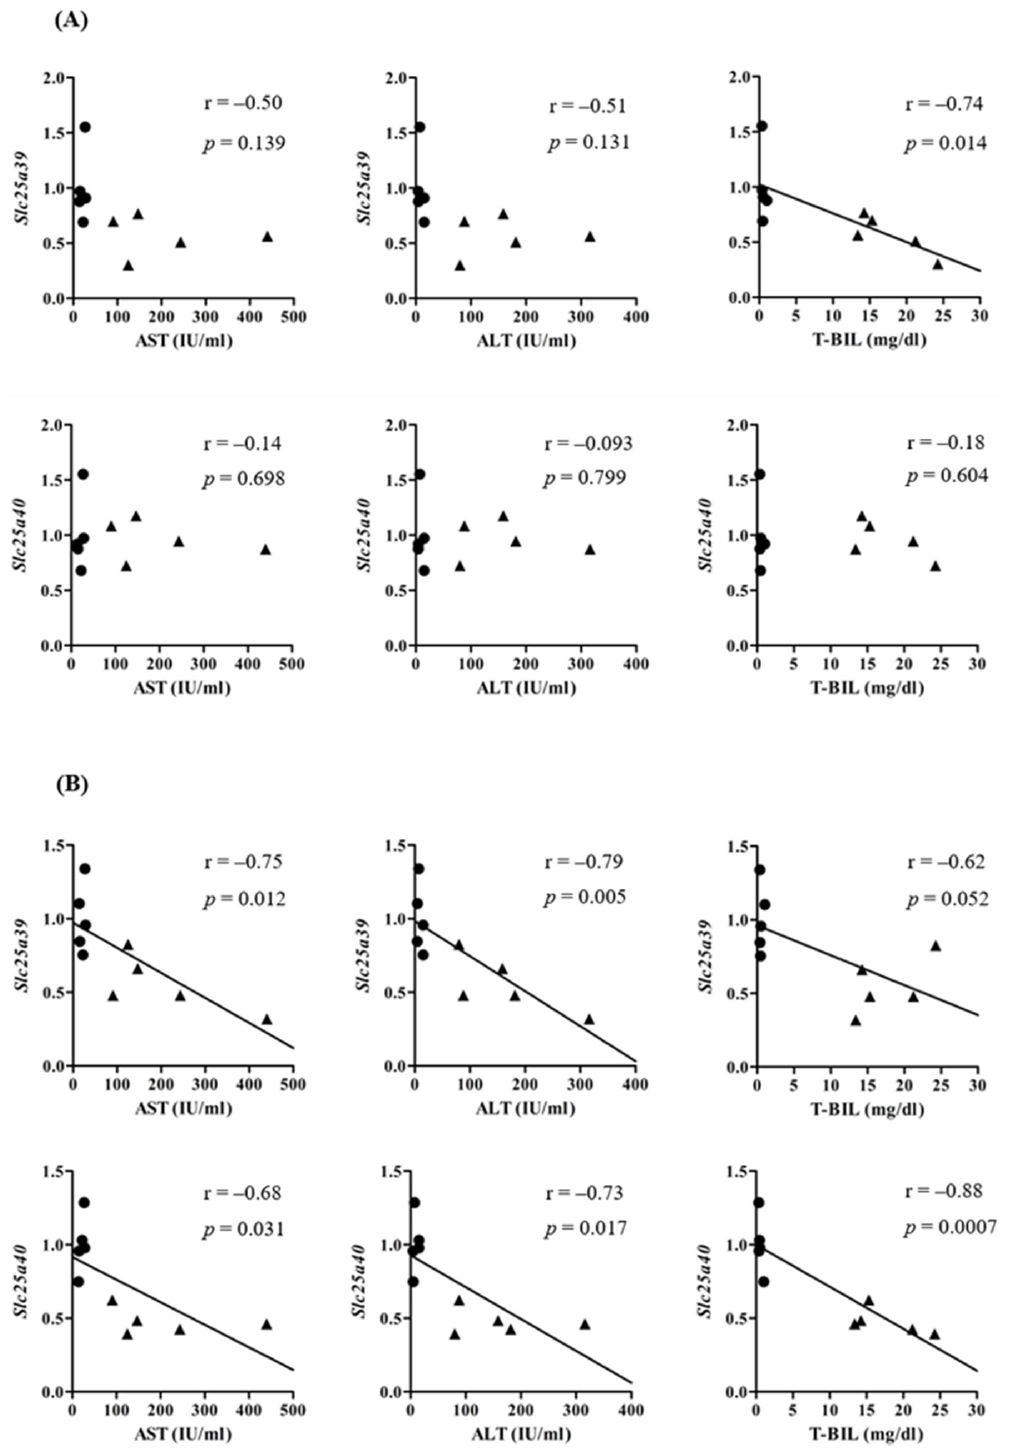
Figure 3. Correlation between aspartate aminotransferase (AST; IU/mL), alanine aminotransferase (ALT; IU/mL), or total bilirubin (T-BIL; mg/dL), and relative mRNA levels of Slc25a39/40 in the liver ( A ) and kidneys ( B ) of sham and bile duct ligation (BDL) mice. Closed circles and triangles represent sham and BDL mice, respectively.